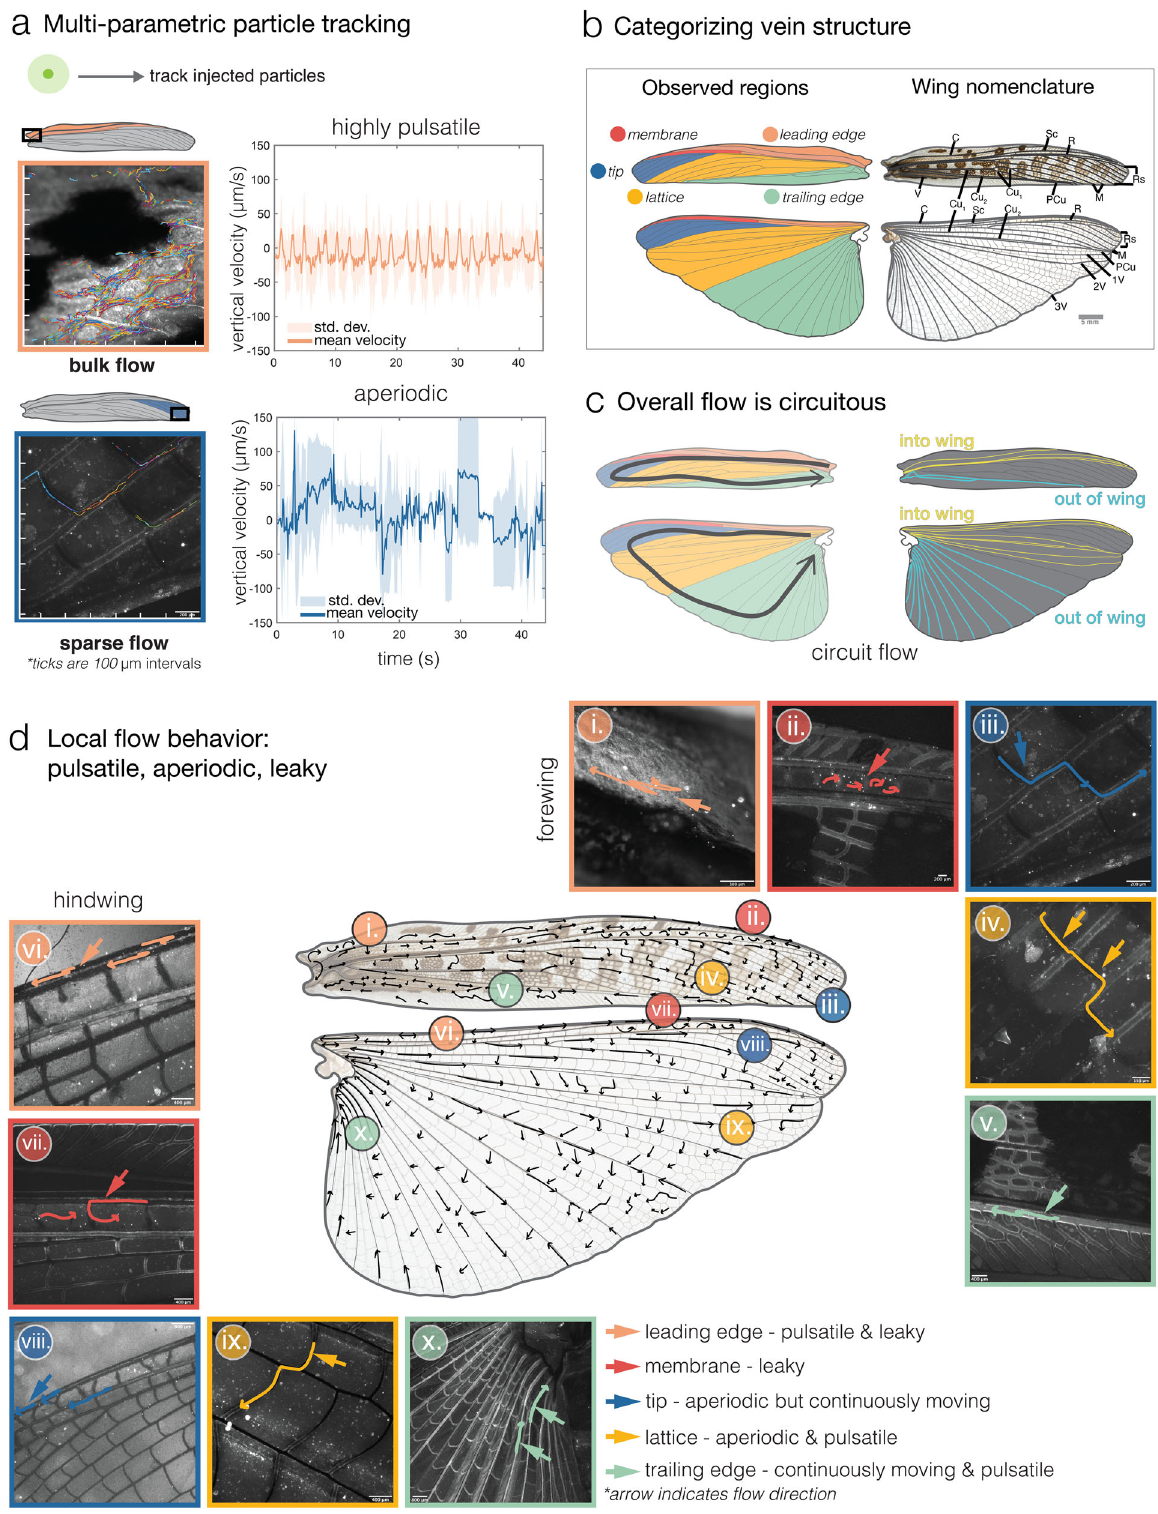
appears to be a function of proximity to the body and its associated pumping organs (Fig. 3d). Hemolymph is pumped out of the forewing and hindwing near the trailing edge by each wing ’ s respective thoracic wing heart (Fig. 2b, Supplementary Movie 8), and hemolymph fl ows into